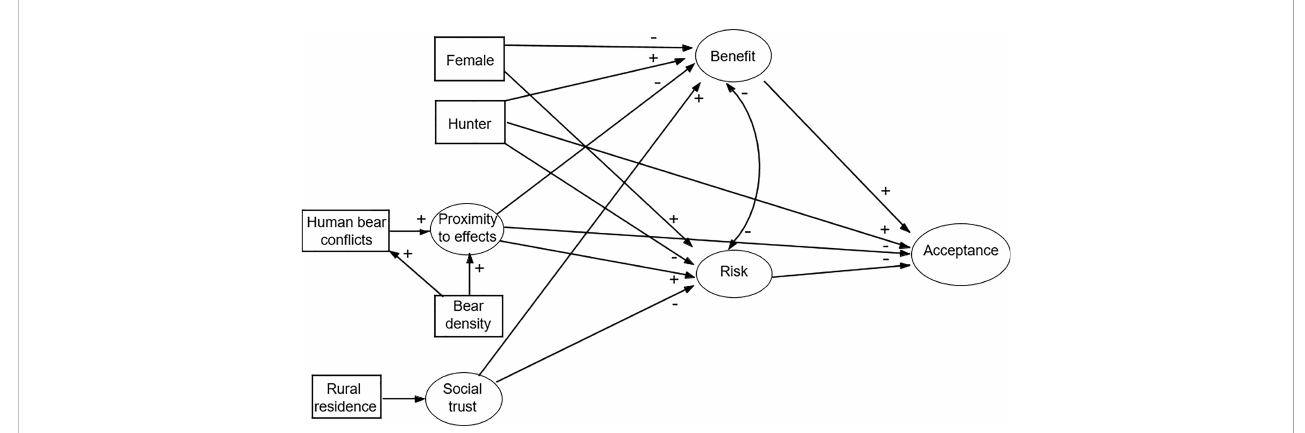
FIGURE 1 Our conceptual model of the ecological, social, and psychological variables that in fl uence acceptance capacity for black bears ( Ursus americanus) in New York State, USA. Straight lines represent hypothesized paths between variables. Curved lines represent hypothesized covariance between variables. Plus and minus signs indicate hypothesized direction of relationship between variables. Proximity to effects refers to perceived proximity to effects of human-bear interactions. Social trust refers to trust in the agency that manages black